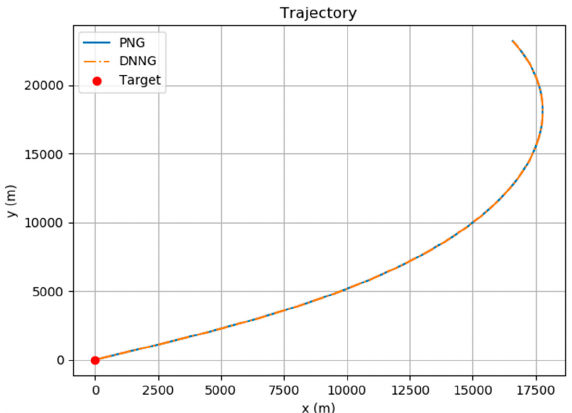
Figure 8. Comparison of the trajectory of PNG and DNNG laws.